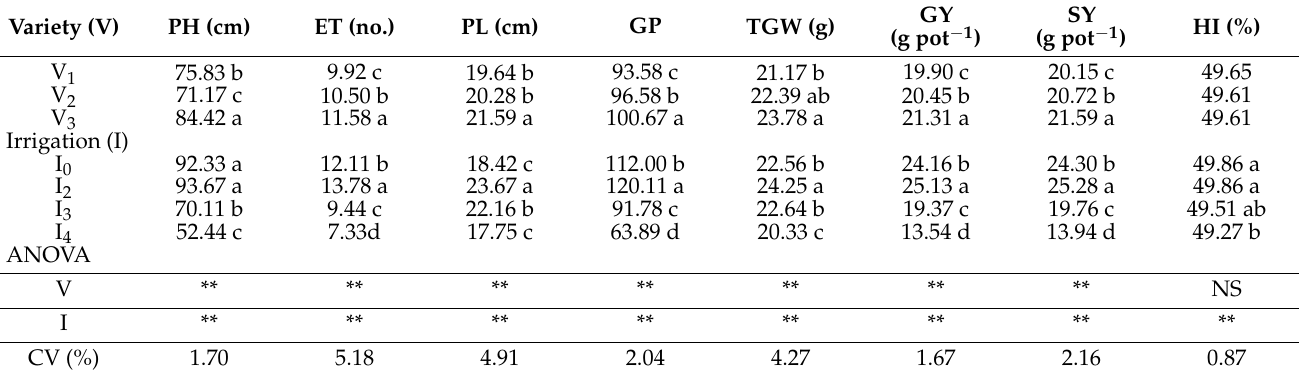
Table 1. Yield attributes of the three rice cultivars under the four irrigation regimes.